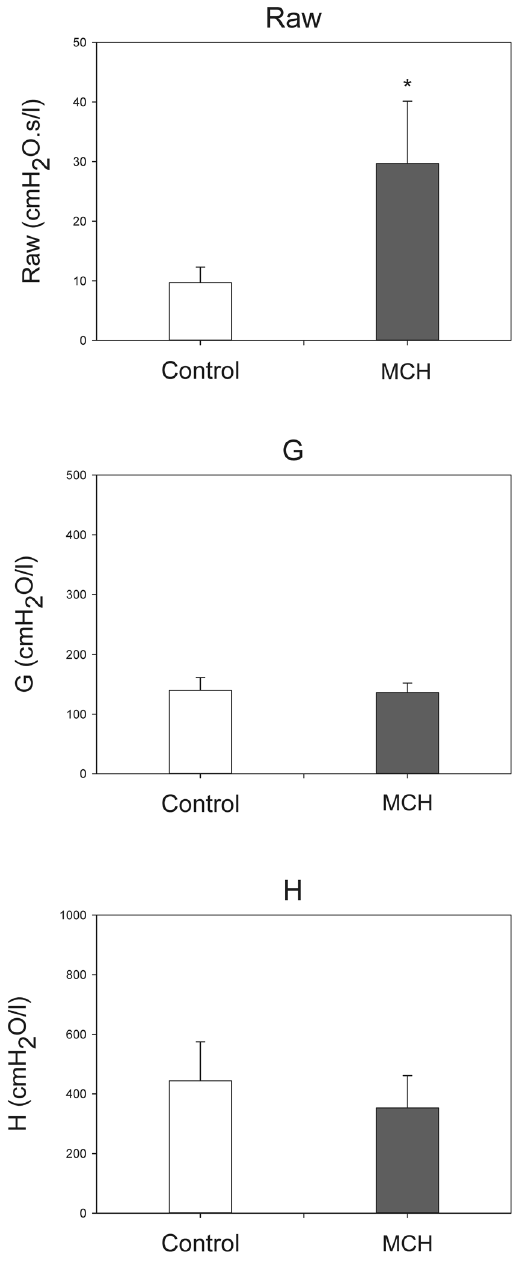
Figure 3. Respiratory mechanical parameters measured by forced oscillations. Data are m ± SD, n = 6 in each group. * p < 0.05 vs.